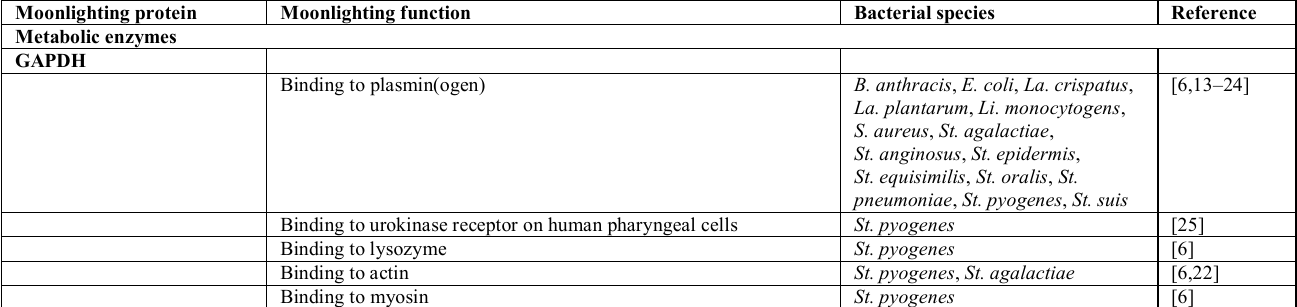
Table 1. Bacterial moonlighting proteins binding to host